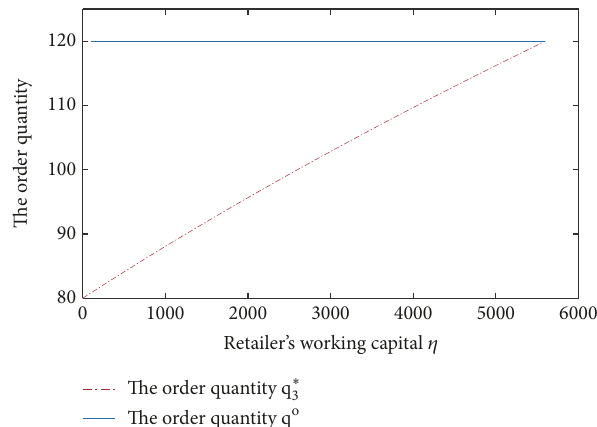
Figure 5: Change trend of order quantity with retailer’s working capital 𝜂